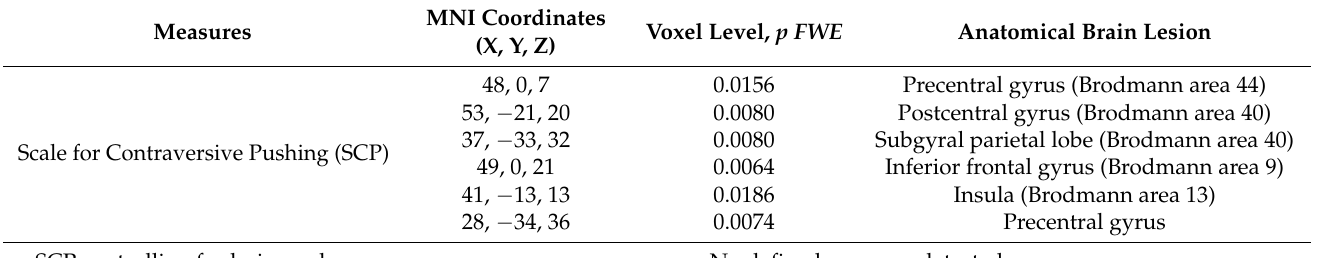
Table 3. MNI coordinates of brain lesions associated with